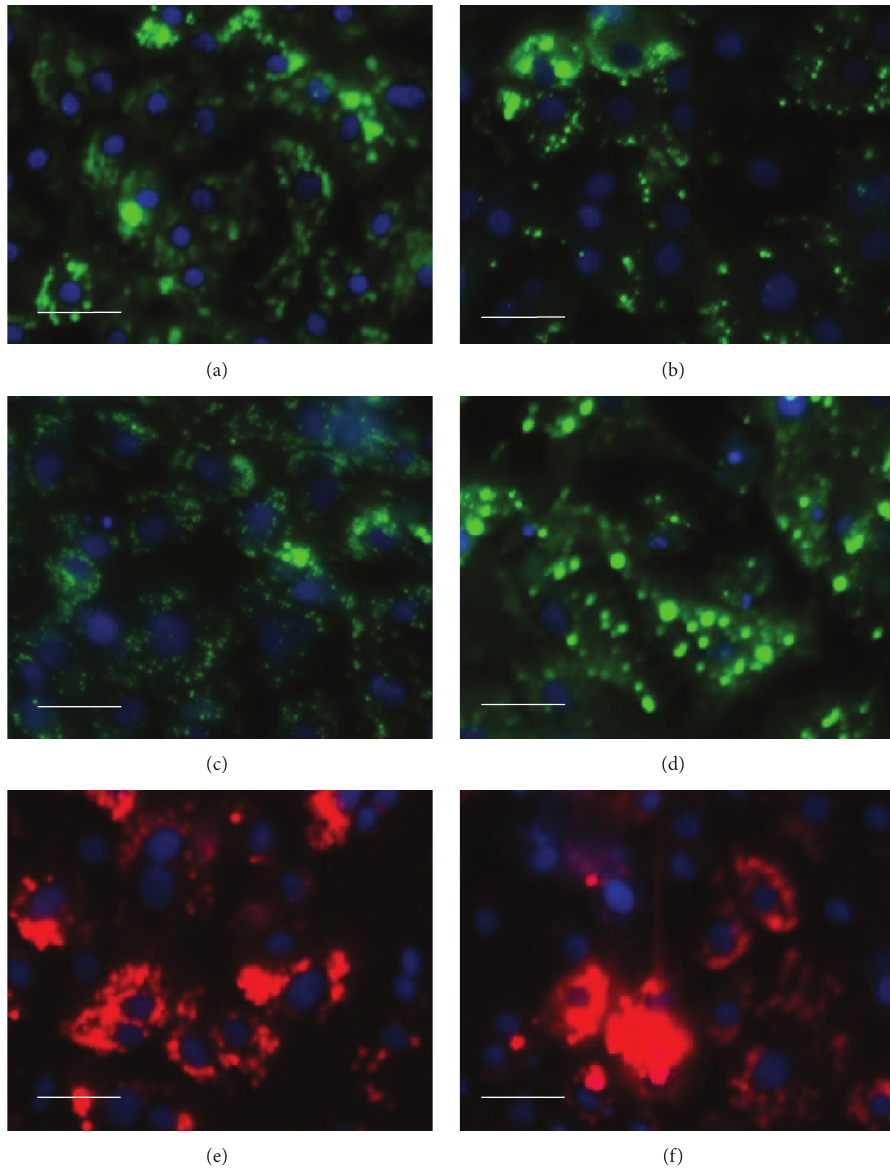
Figure 4: High magnification images of drug induced neutral lipid accumulation in droplets of hiPS derived hepatocytes (LipidTox Green) by amiodarone 12,5 𝜇 M (a), doxycycline 32 𝜇 M (b), tetracycline 100 𝜇 M (c), and cyclosporine A 30 𝜇 M (positive control, d) and drug induced phospholipidosis (LipidTox Red) by amiodarone 12,5 𝜇 M (e) and propranolol 30 𝜇 M (positive control, f). Nuclei are stained blue by DAPI. Scale bar 50 𝜇